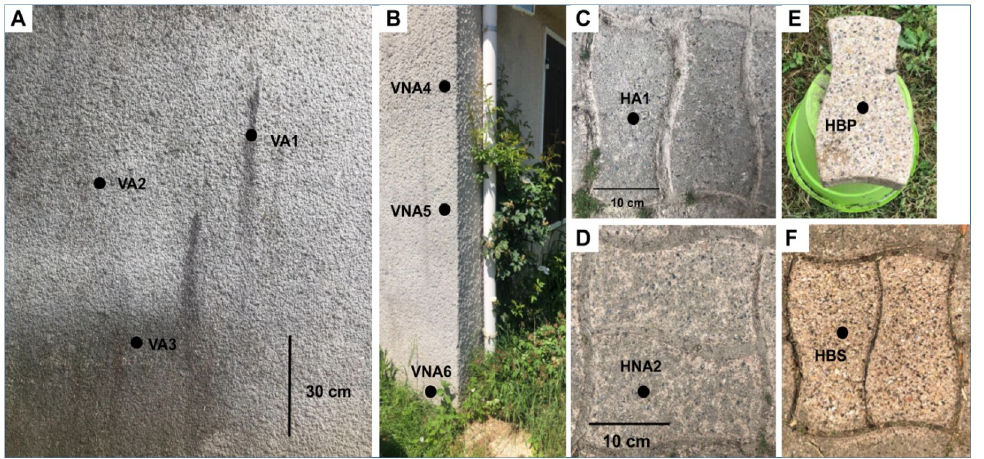
Fig 1. Spring campaign measurement zones. Vertical positions sheltered by tree (A) and not sheltered (B), horizontal positions sheltered by tree (C), not sheltered (D), horizontal bleach-washed tiles (E & F). E is not in contact with other tiles and soil contrary to